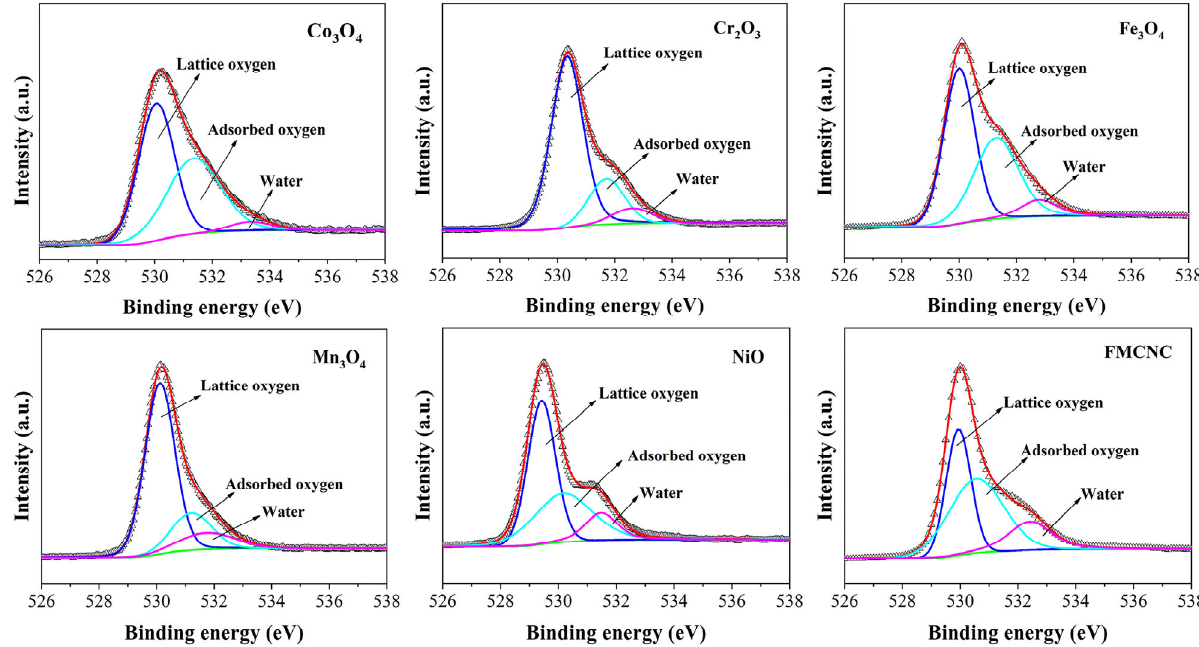
Fig. 4 XPS O 1s binding energy for FMCNC high-entropy oxide and its individual components (Fe 3 O 4 , Mn 3 O 4 , Co 3 O 4 , NiO, and Cr 2 O 3